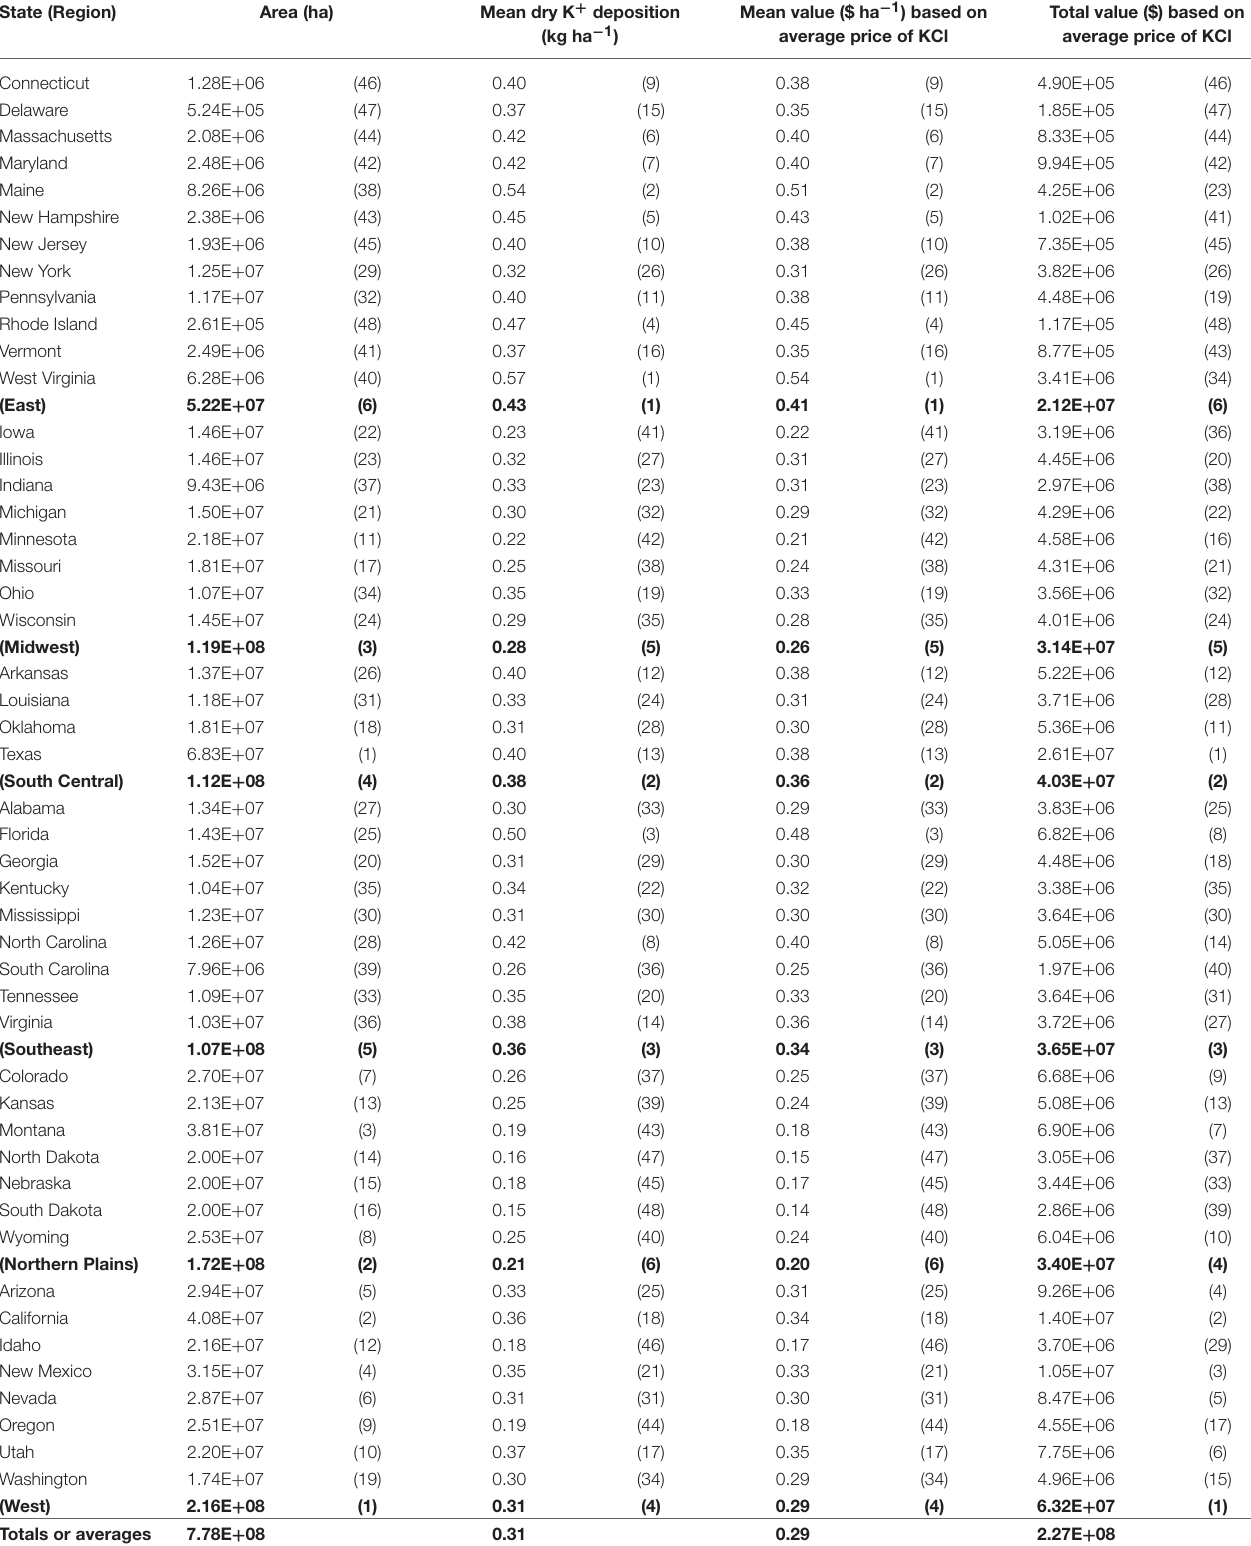
Bold type indicates regions consisting of the states listed immediately